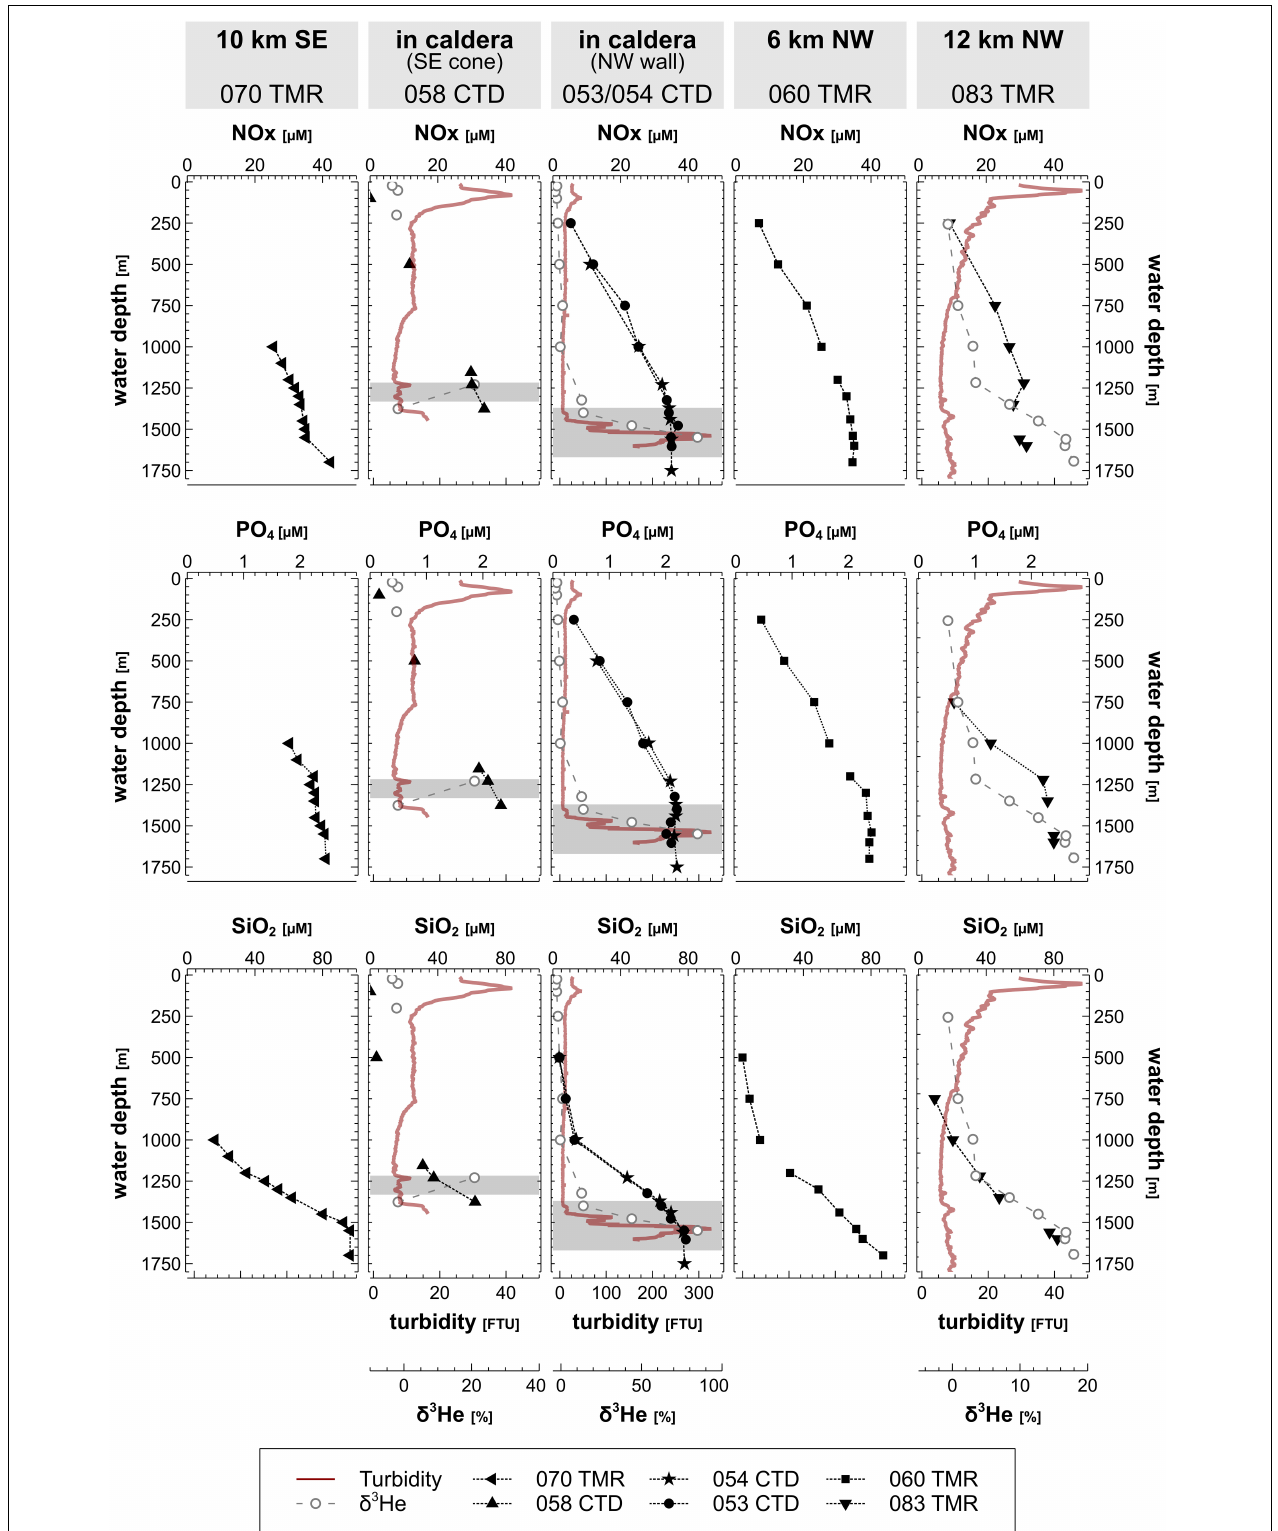
FIGURE 9 | NO x , PO 4 , and SiO 2 data for six different CTD casts over the Brothers volcano, together with δ 3 He and turbidity data. No δ 3 He and turbidity data are available for TMR casts, i.e., TMR 070 and TMR 060. δ 3 He and turbidity data for TMR 083 were taken from CTD 082, which was conducted at the same location and same day. The gray areas in the plots of the CTDs taken within the caldera indicate depths of the hydrothermal vent sources (Kleint et al., 2019).